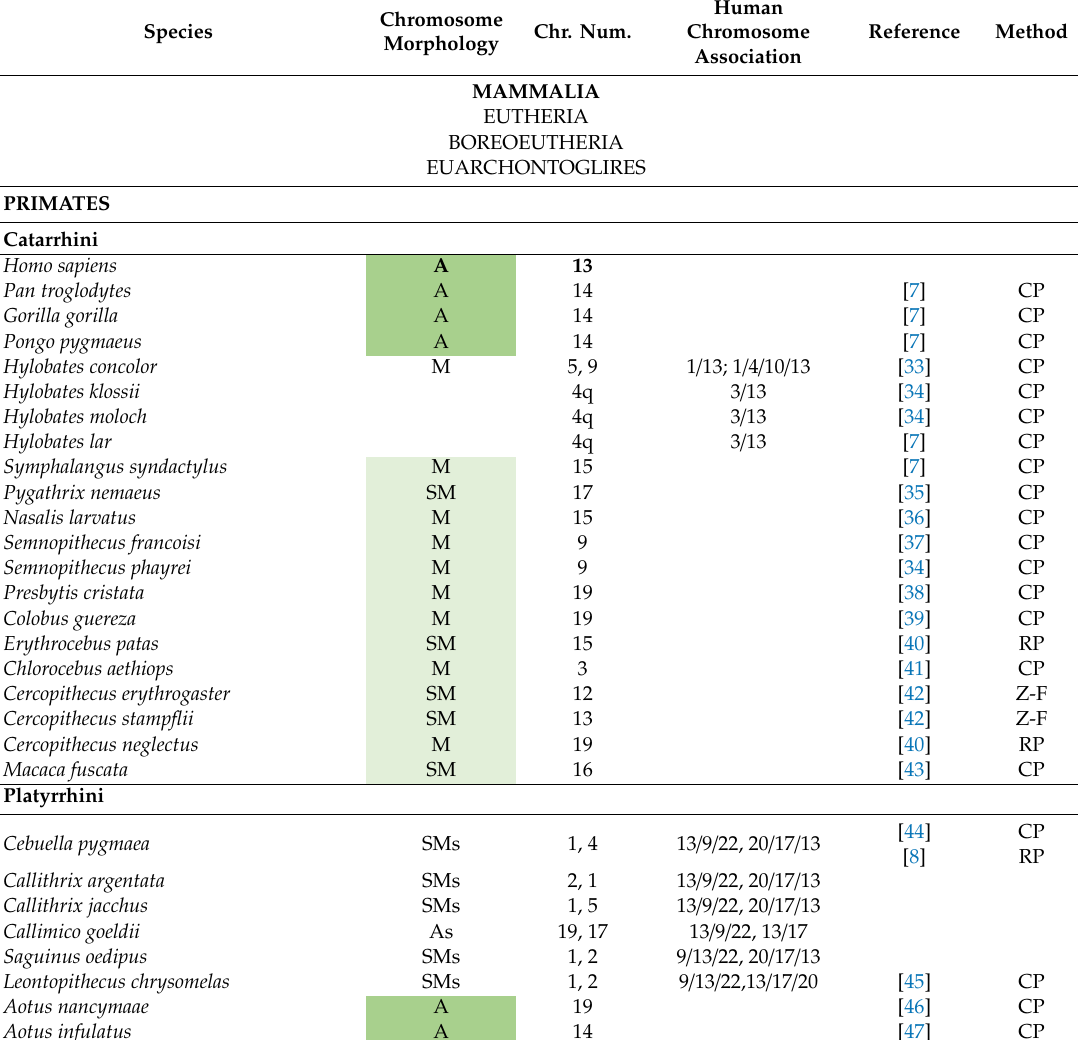
Table 2. The list of species analysed by Chromosome Painting (CP), Reciprocal Painting (RP), Zoo-FISH (Z-F) and / or comparison of Sequence Alignments (SA) and respective references. For each species, human chromosome 13 homologues and other human associations are reported. The * indicates an alternative chromosome identification reported in a di ff erent reference. The shaded areas in the second column indicate ancestral conserved state of human chromosome 13 (HSA13) synteny as a